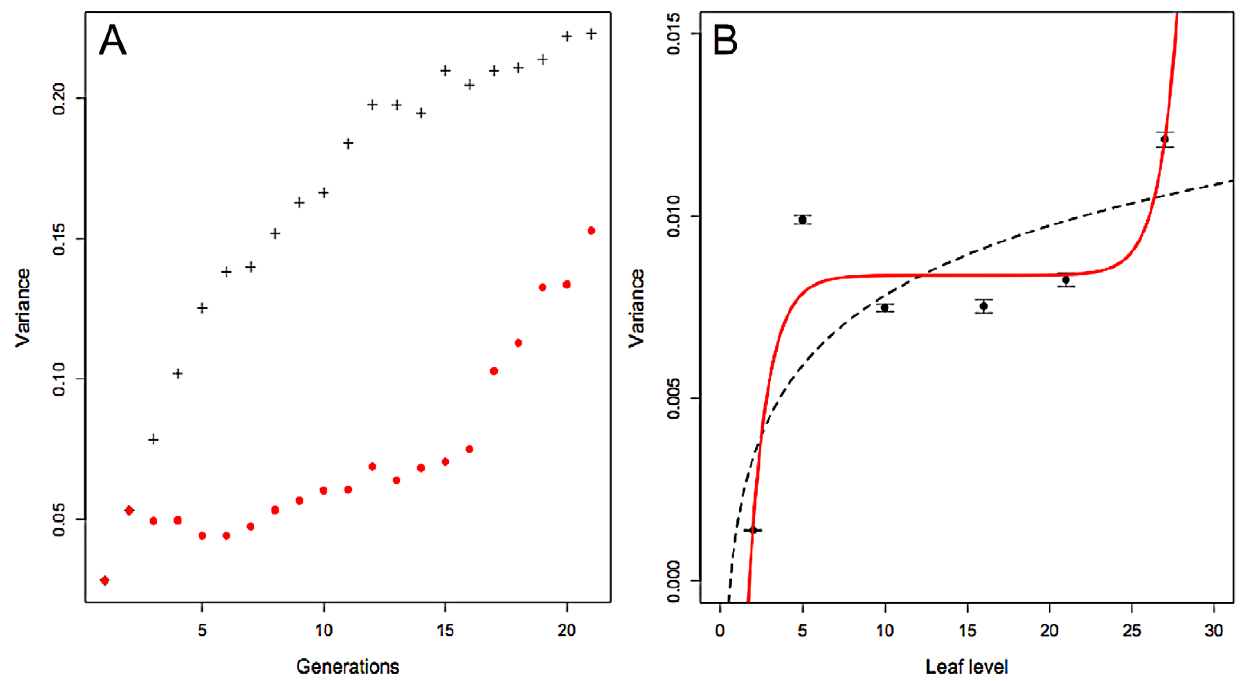
Figure 3. Monitoring of the bottleneck size changes during disease progression. A . Among-populations variance of allele frequency of a diallelic neutral locus over time when the effective size of each population is (i) always equal to 10 (black crosses); (ii) equal to 10 until generation 2, then equal to 100 until generation 15, and then equal to 10 again (red circles). All populations start with the same initial allele frequency of 0.5. B. At each indicated leaf level, the variance of Mys4 frequency was estimated among 40 replicate plants. The equi-competitiveness of Mys4 and Mys7 was again confirmed in this experiment, by showing that the linear regression of Mys4/Mys7 relative frequency over time is not different from 0 (p- value=0.053; not shown). Confidence limits for variance values were obtained as in Figure 2B. Error bars indicate standard errors. Two functions were fitted to the variance values obtained over time. Red line: a hyperbolic-sinus function with the formula: y=d*(b/d + sinh(c*(x 2 a))); where a=14.84, b=8.37E-03, c=0.87 and d=2.28E-07; this function has an AIC= 2 54504.68. Dashed line: a logarithmic function with the formula: y=a + b*ln(x); where a=1.45E-3 and b=2.764E-3; this function has an AIC= 2 52021.35.